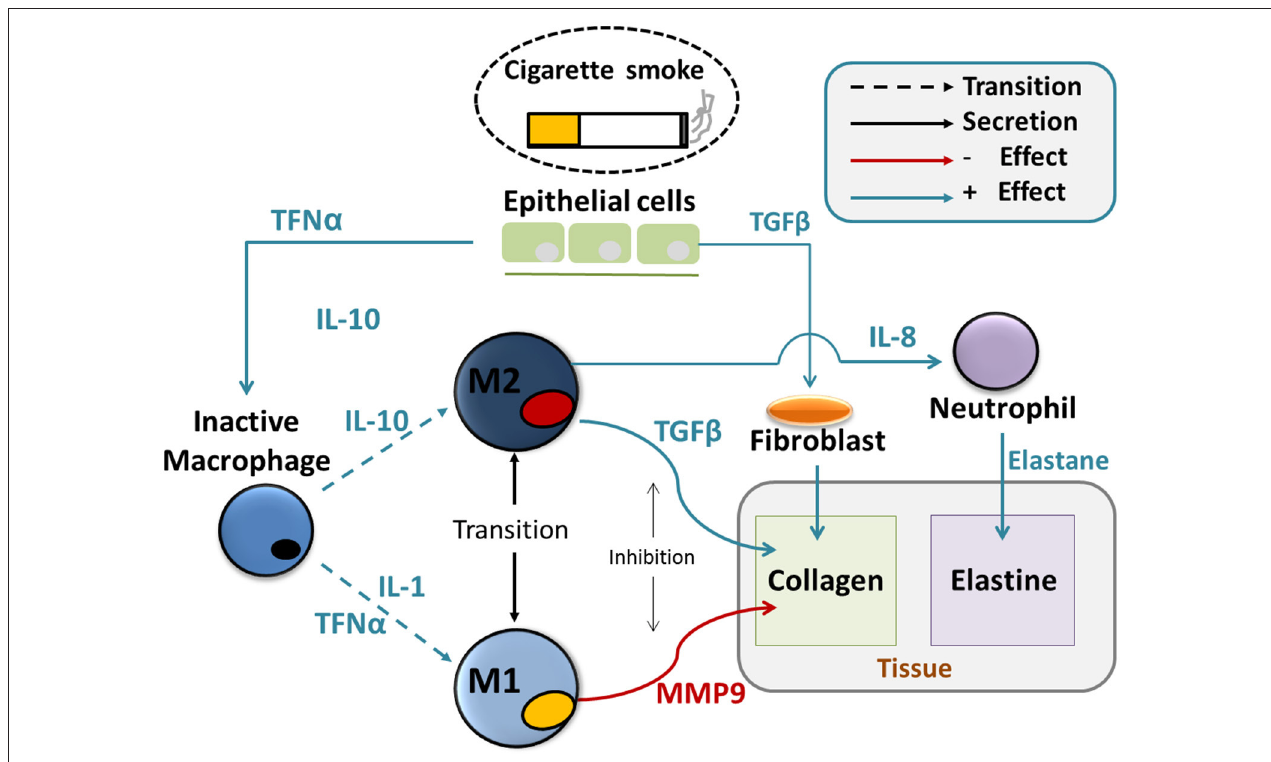
FIGURE 1 | Agent based model of tissue destruction in emphysema progression. Particles coming from inhaled smoke cause secretion of cytokines such as TNF α and TGF β by the epithelial cells. Those act, at first, as chemotactic factors and attract undifferentiated alveolar macrophages and fibroblasts. and the alveolar macrophages. Secondly, they induce the activation of the macrophages and their differentiation in the M 1 and M 2 subtypes. Those will create a delicate dynamical balance between inflammatory and anti-inflammatory signals such as IL 1 , IL 8 , and IL 10 that affect the activation of protease such as MMPs, the recruitment of neutrophils and fibroblasts. MMPs directly cleavage the collagen from the tissue and are responsible for the deposition of abnormal collage that leads to fibrosis, together with fibroblasts. Elastase destroys the elastin in the tissue. Both abnormal collagen deposition and reduction in elastin deteriorate the mechanical properties of the